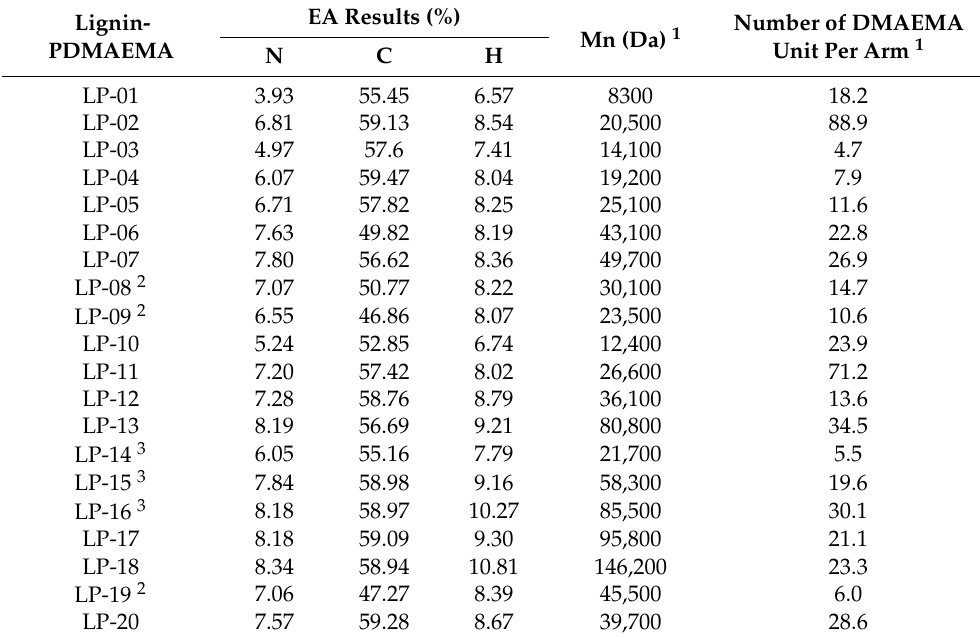
Table 4. The selected EA results for lignin-PDMAEMA